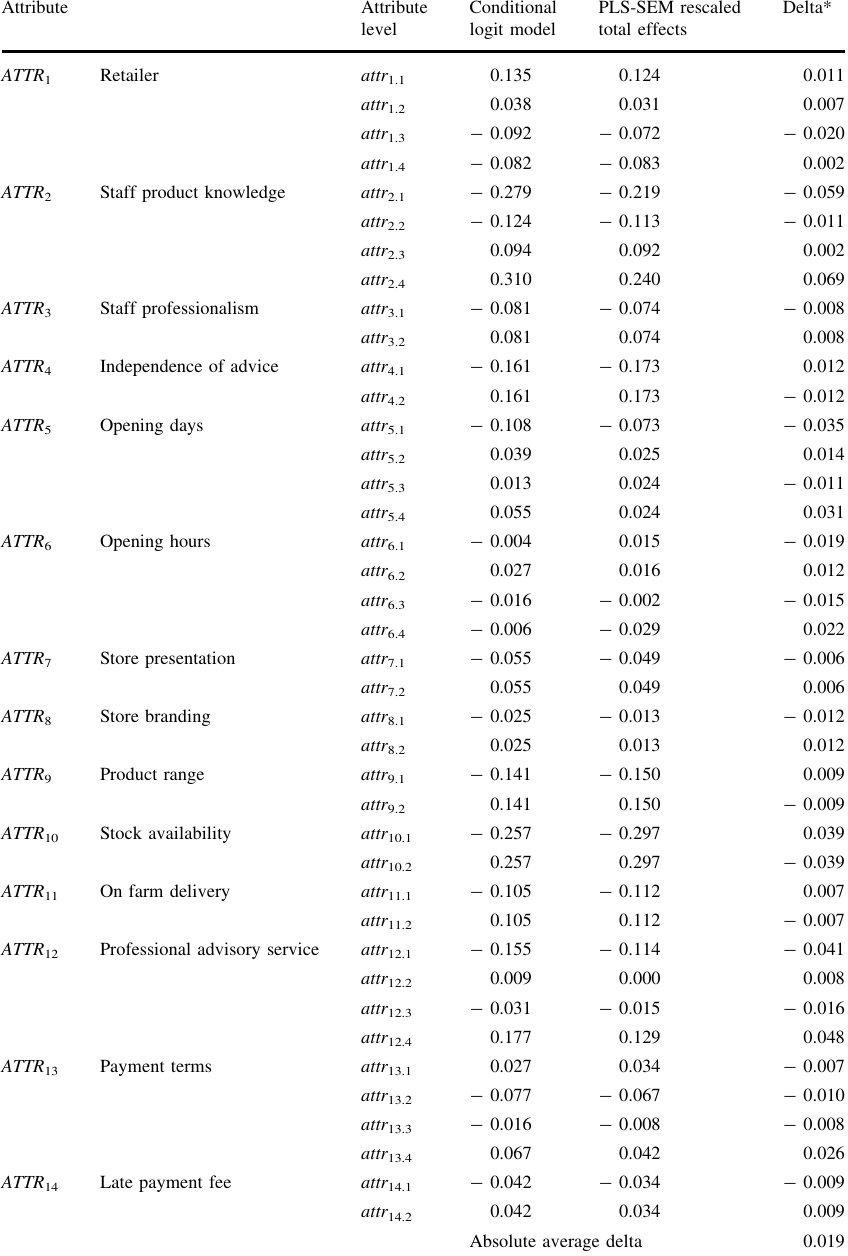
Table 2 Cross-validation of